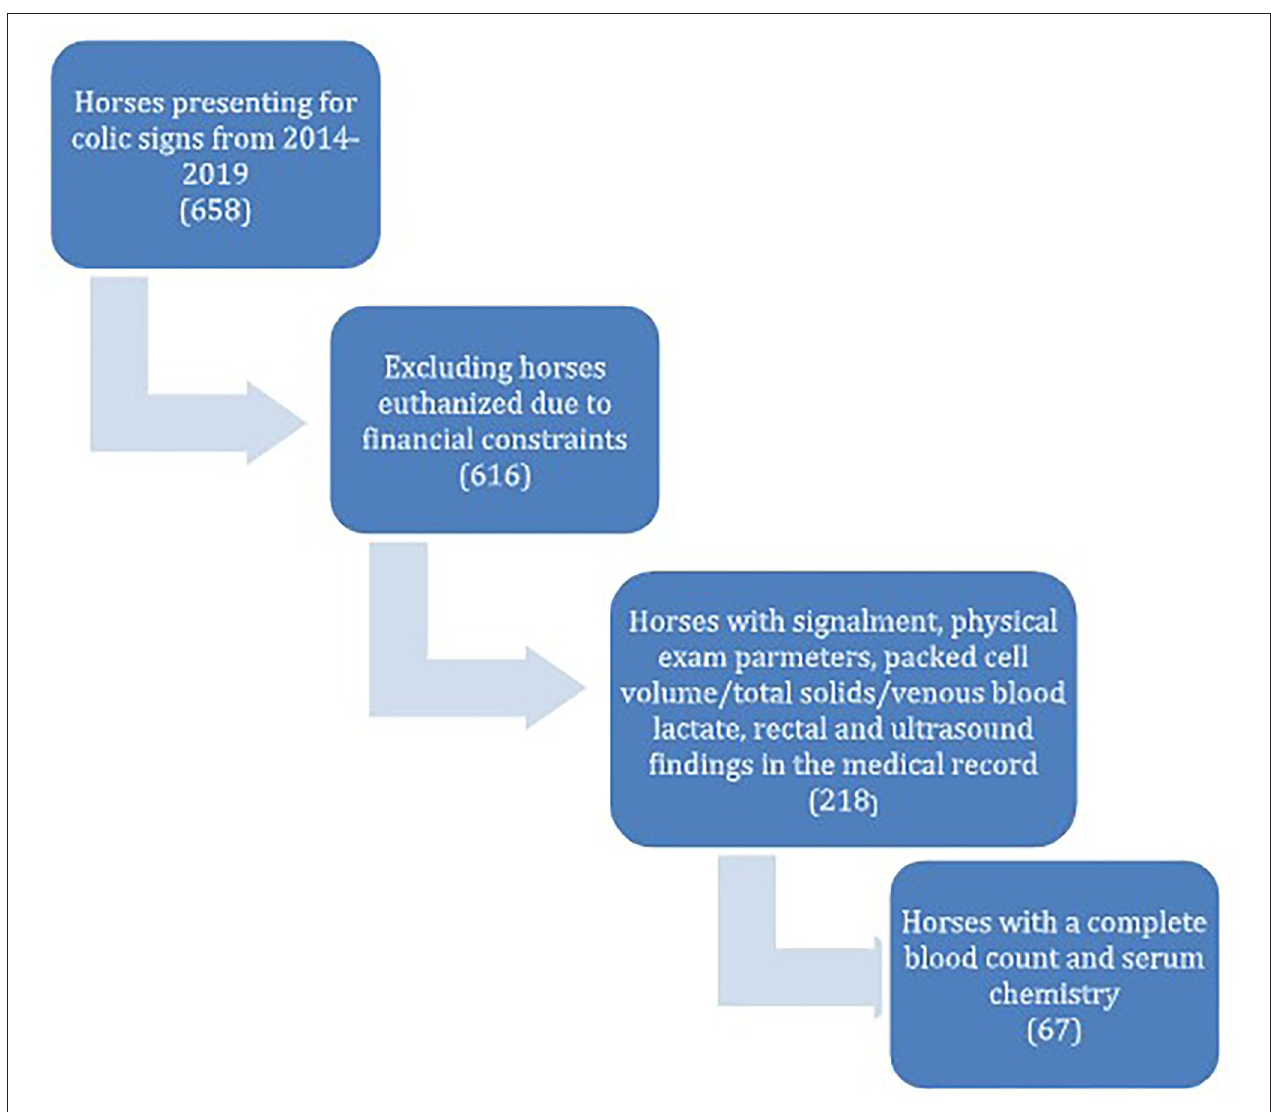
FIGURE 1 | Flow chart depicting case selection for the retrospective population of the